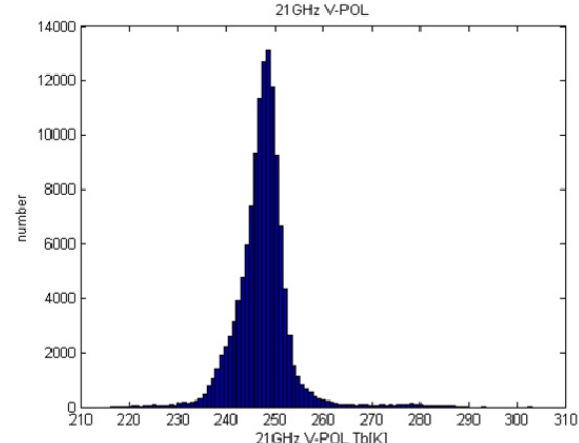
Figure 5. Histograms of the TB for the TMI in the absence of rain at 19 GHz: ( a ) TB10V and ( b ) TB10H.